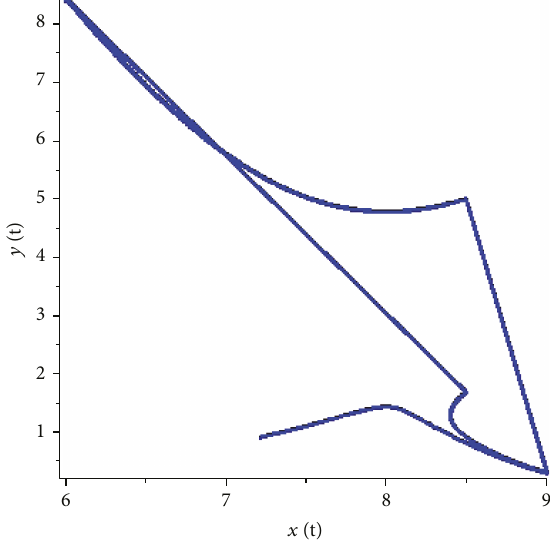
Figure 24: There exists an order-2 periodic solution in system (16) with q 1 = 1/18 , p = 0 8 , and τ = 4 7 .